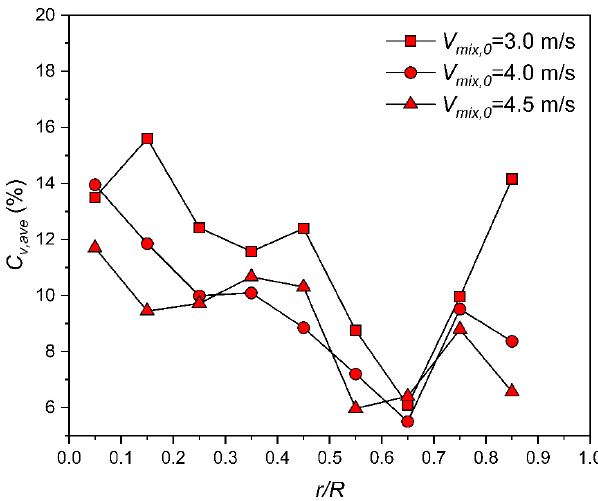
Figure 16. Effects of initial mixture velocity on average SVF ( C v ,0 = 5%, d s = 15.0 mm).